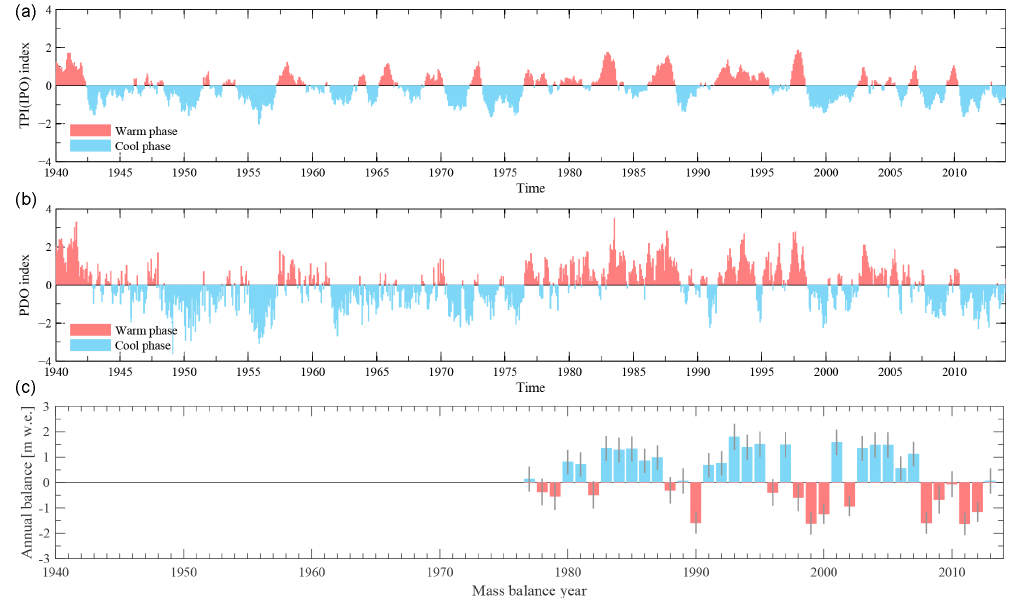
Figure 16. (a) Tripole Index for the Interdecadal Pacific Oscillation (TPI/IPO) computed from ERSSTv3b (Henley et al., 2015). (b) Pacific Decadal Oscillation (PDO) (Mantua et al., 1997). (c) Reconstructed mass balance record over the period of the EOSS